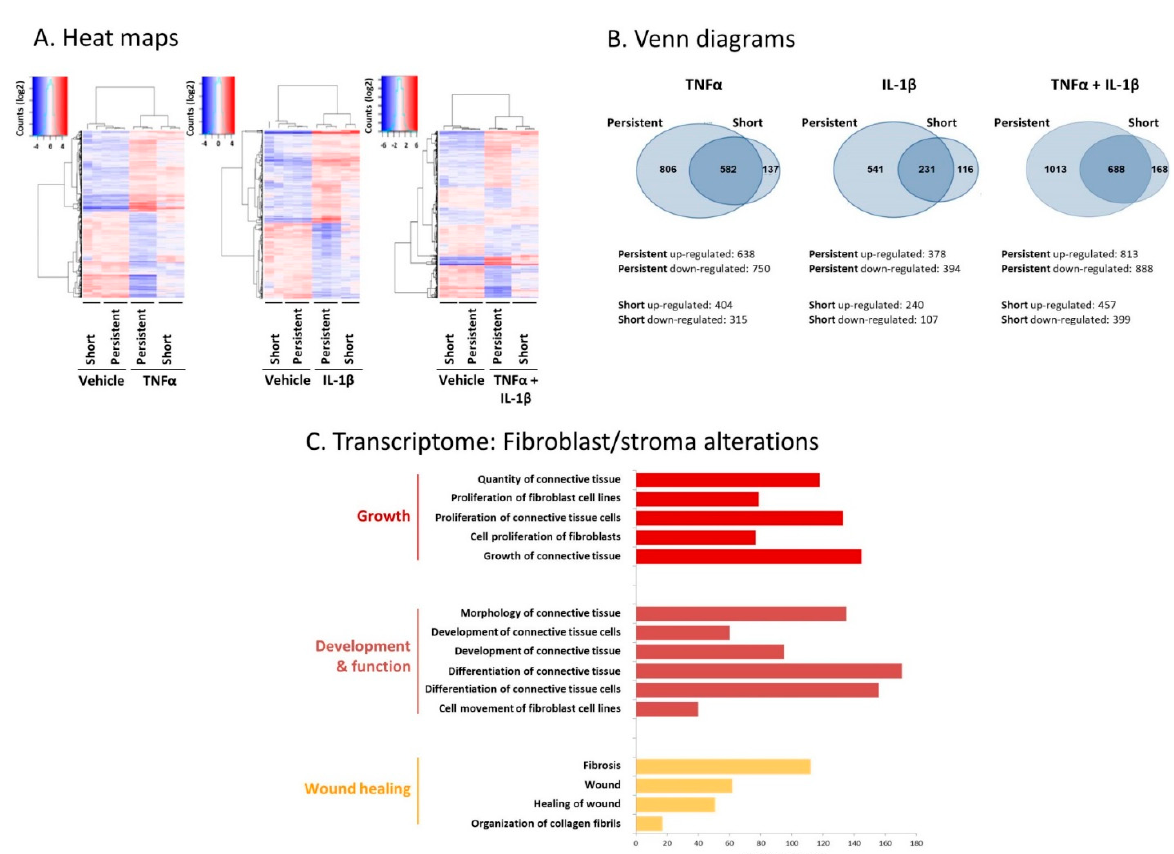
Figure 2. Persistent stimulation of MSCs by TNF α + IL-1 β leads to prominent alterations in gene expression and in fibroblast-relevant transcriptional programs in the resulting CAF-like cells. Human MSCs were exposed to “persistent” stimulation by TNF α and/or IL-1 β for 14 days or to “short” stimulation of 48 h (concentrations as in Figure 1) in three independent biological repeats, followed by RNAseq analyses. Control cells were treated using the vehicles of the cytokines. ( A ) Heat maps. Deseq-normalized counts, values were centered. ( B ) Venn diagrams. Upregulated genes: FC > 2, padj < 0.05; downregulated genes: FC < 0.5, padj < 0.05. ( C ) Fibroblast-relevant transcriptional programs that were significantly modified by persistent TNF α + IL-1 β stimulation, at FC > 2 or FC < 0.5 and padj < 5 × 10 − 10 , are demonstrated.